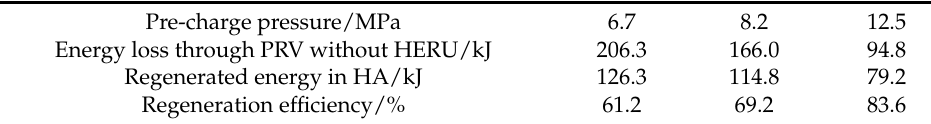
Table 1. Energy regenerated with different pre-charge